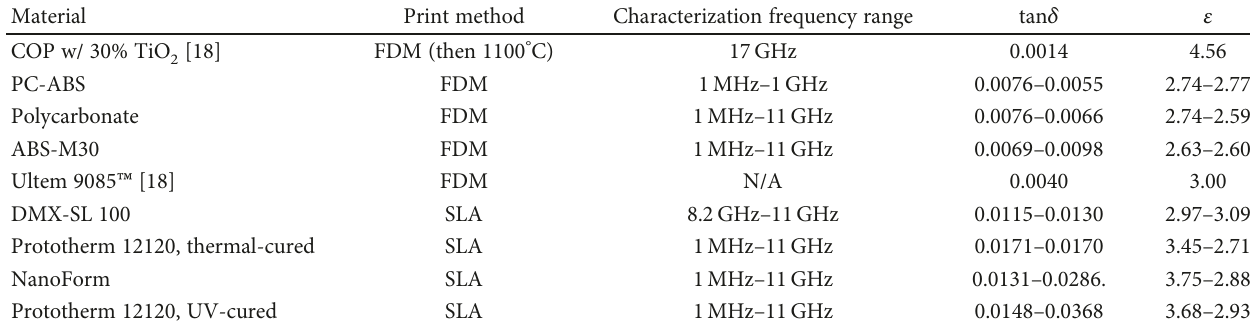
Table 2: Comparison of RF parameters for printed dielectrics